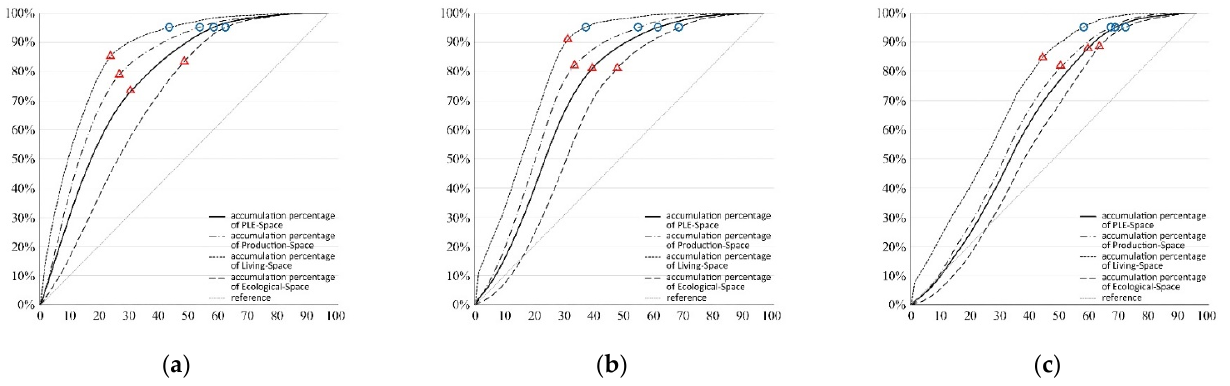
Figure 6. PLES cumulative curves of location factors. ( a ) Distance to subdistricts; ( b ) distance to cities; ( c ) distance to capitals